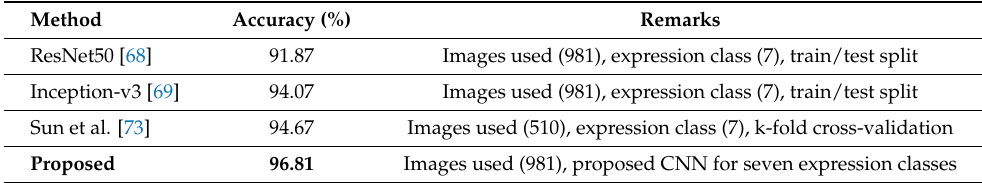
Table 9. Performance comparison of the proposed FERS for the CK+ database.